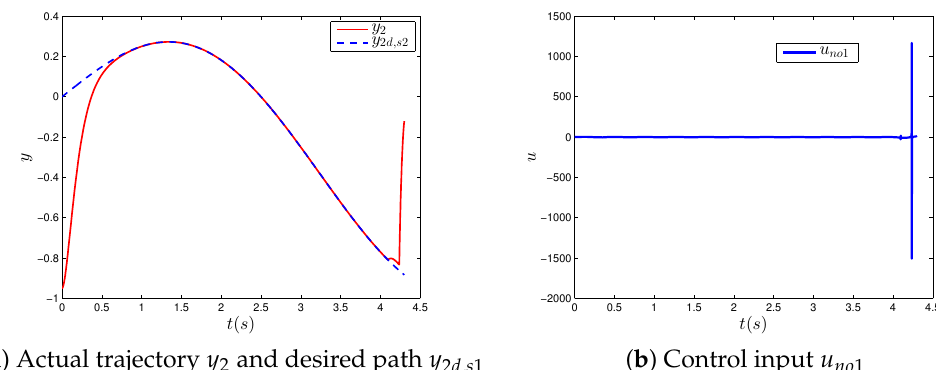
Figure 7. Tracking performance of ZD controller (25) to solve the tracking control problem with single nonlinear output of the single-link manipulator with flexible joints for the desired path y 2 d , s 1 = sin ( 0.1 π t ) cos ( 0.2 π t ) .